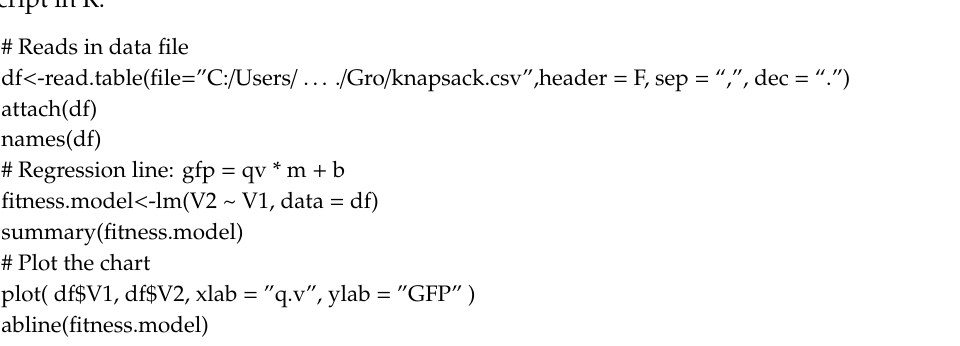
Figure A2. Lac operon selection routine implemented in Gro language for the 0 / 1 knapsack problem. ( 1 ) Declaration of interactions between signals. The first-order reaction simulates the degradation of biomass (b) by an enzyme (e), i.e., a protein acting as a metabolic reaction catalyst, from which the resulting product is glucose (f). A second reaction command simulates the degradation of lactose by lacZ (operon_lac), resulting in glucose and galactose (f_lac). The third reaction command simulates the degradation of galactose (f_lac) by an enzyme (e). ( 2 ) Effect of glucose (f) on bacterial growth rate. ( 3 ) Conditional sentences of the Lac operon. ( 4 ) Glucose and lactose signals are randomly distributed in the environment where the colony of synthetic bacteria grows.